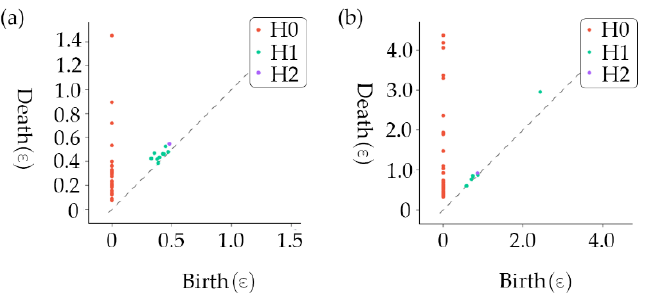
Figure 5. ( a ) The control subjects in the stance phase of the left foot ( b ) The Parkinson’s disease (PD) subjects in the stance phase. The abscissa is the appearance time of the structure, and the ordinate is the disappearance time. H0, H1, and H2 are the homology structures of 0-dimensions, 1-dimension and 2-dimension, respectively.